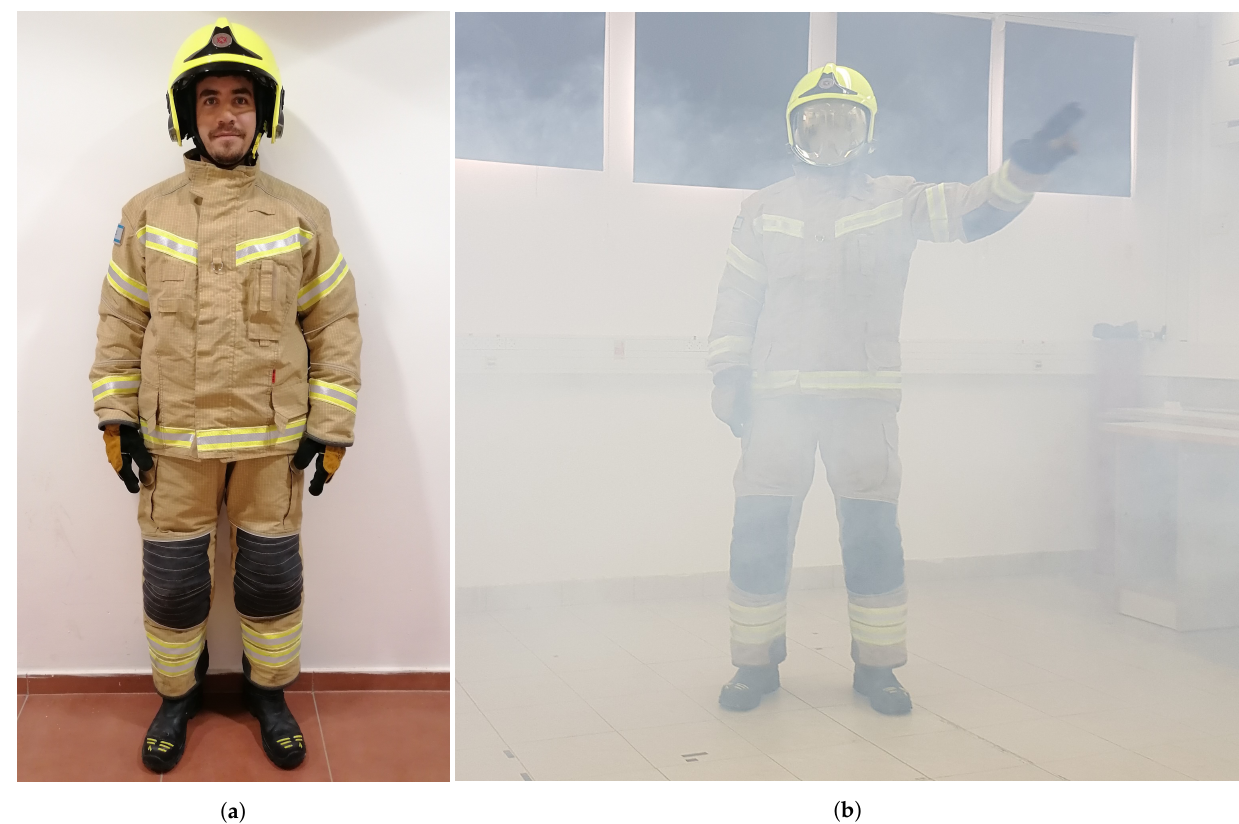
Figure 6. ( a ) Firefighting equipment including helmet, jacket, trousers, and gloves and ( b ) experiment conducted to evaluate the system’s accuracy with full equipment and smoke. Table 2. Recognition accuracy results for each sensor and algorithm evaluated (see Section